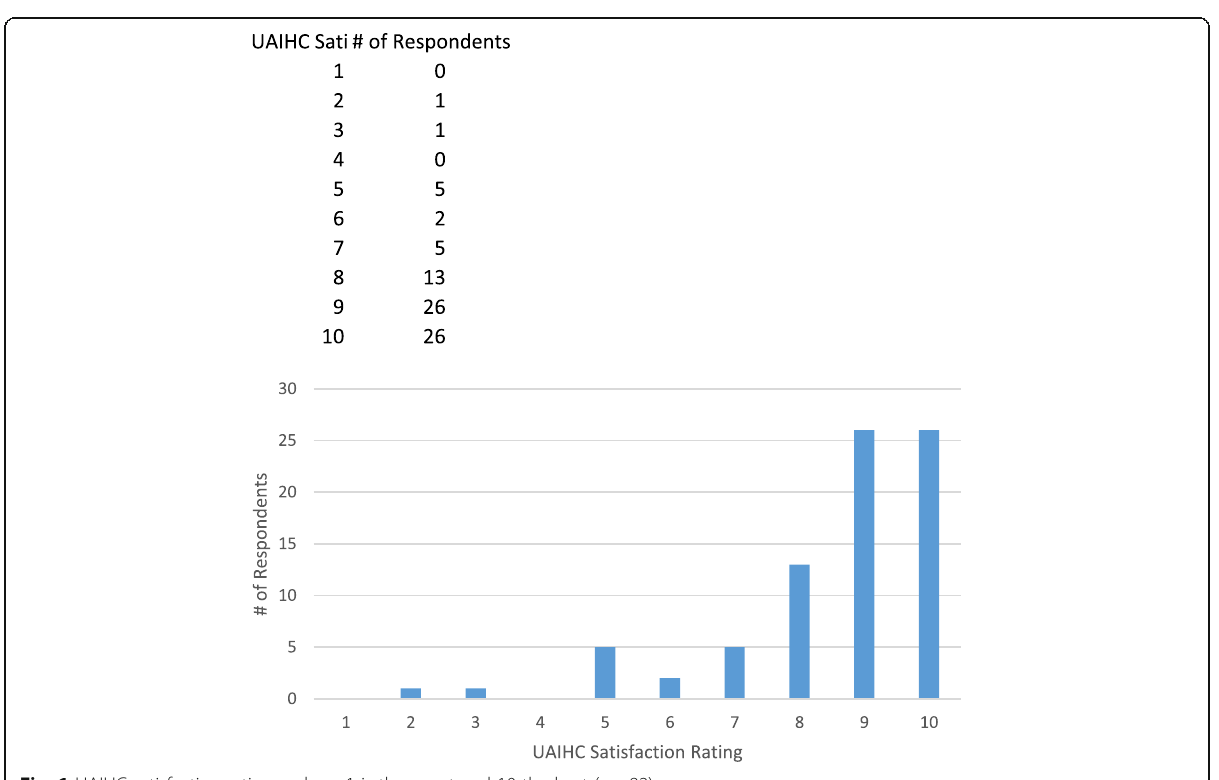
Fig. 1 UAIHC satisfaction ratings, where 1 is the worst and 10 the best ( n =